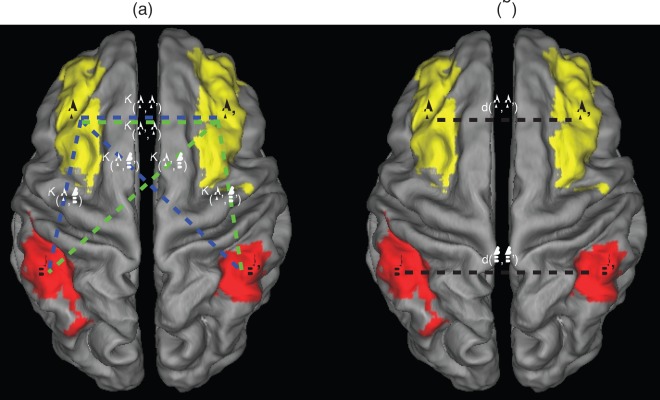
Illustration of two asymmetry measures using a pair of equavelent regions A and A’ for demonstration. a global connectvity asymmetry measure ρ.
The connectivity profile of A (i.e., vetor [K(A,A’), K(A,B’), K(A,B)]) and A’ (vector [i.e., K(A’,A), K(A’,B), K(A’,B’]) are represented by dashed lines of bule and green, respectively. Note that the connectivity K(A,A’) equals K(A’,A), and are both ploted for clarity. b pairwise brain-region synchronization d, which is the standardized Euclidean distance between BOLD signals from equavalent brain regions A and A’, B and B’, respectively (by black dashed lines).